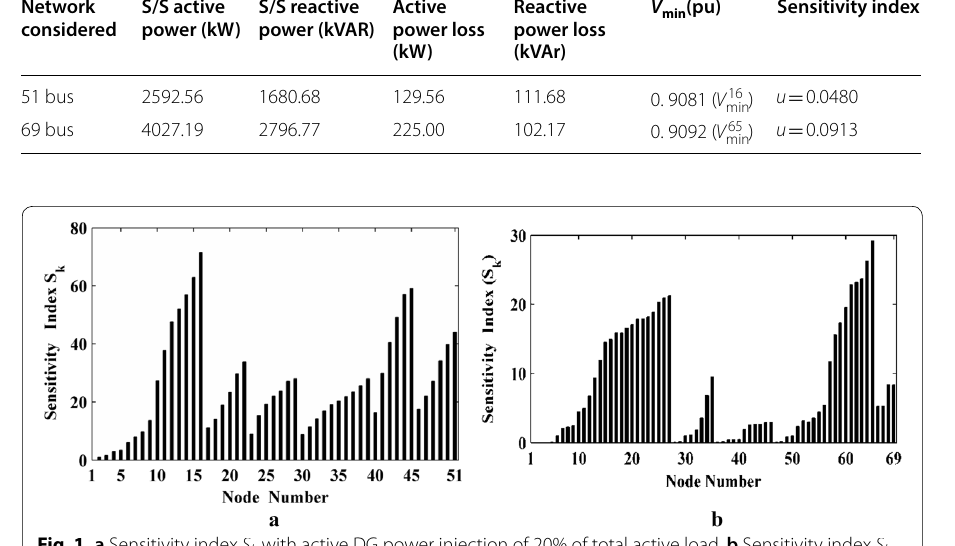
Fig. 1 a Sensitivity index S k with active DG power injection of 20% of total active load. b Sensitivity index S k with active DG power injection of 69-node